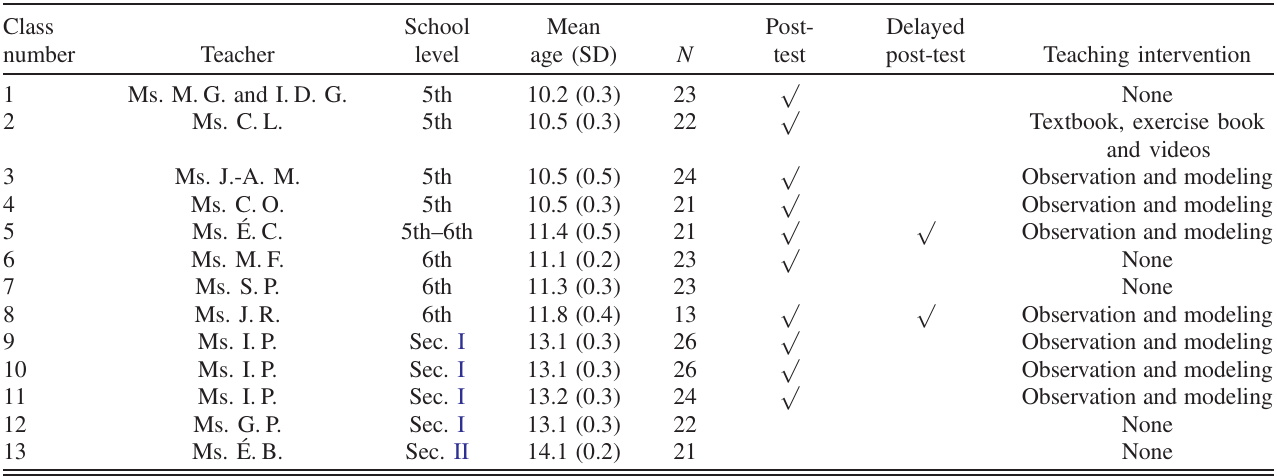
TABLE IV. Demographic data for the 289 students who answered the MPCI-MS at least once (pretest). Post-test, delayed post-test, and teaching intervention (if any) for each class are also identified. “ None ” in the teaching intervention column indicates that students received no instruction whatsoever on lunar phases between the test ’ s administration.